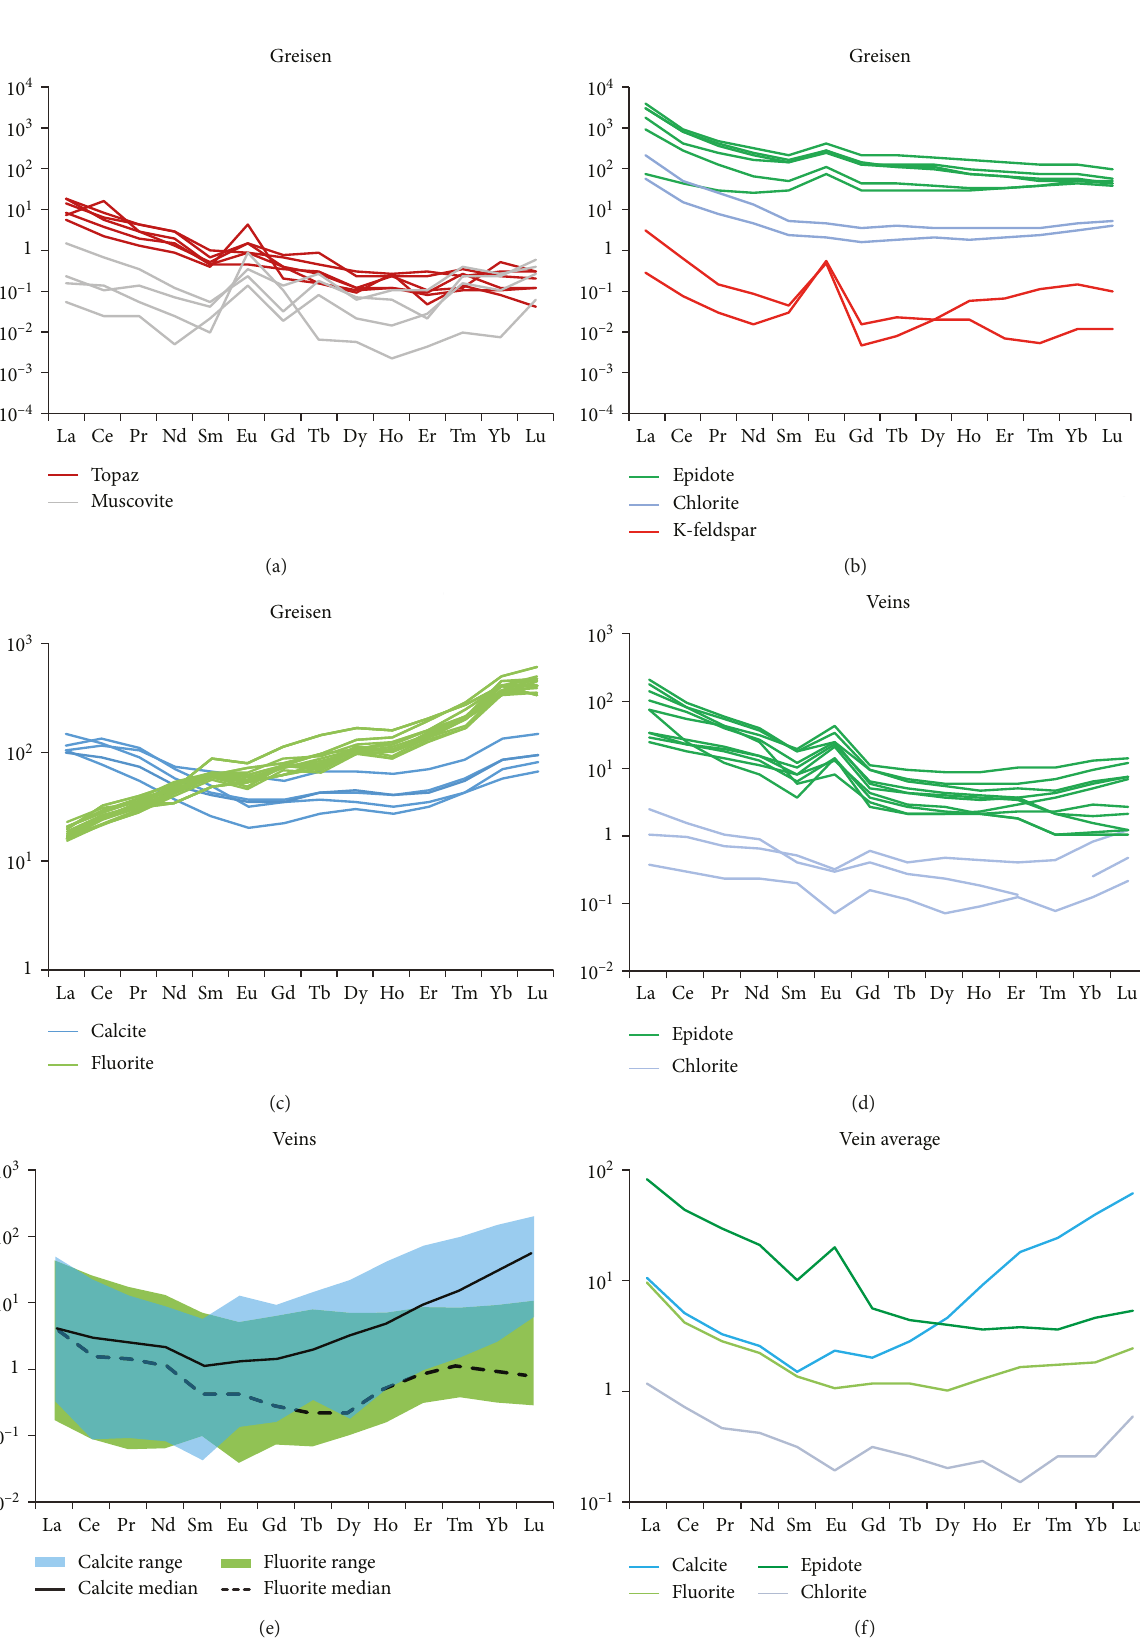
Figure 5: Chondrite-normalized [40] REE concentrations of minerals in (a – c) greisen and (d – f)